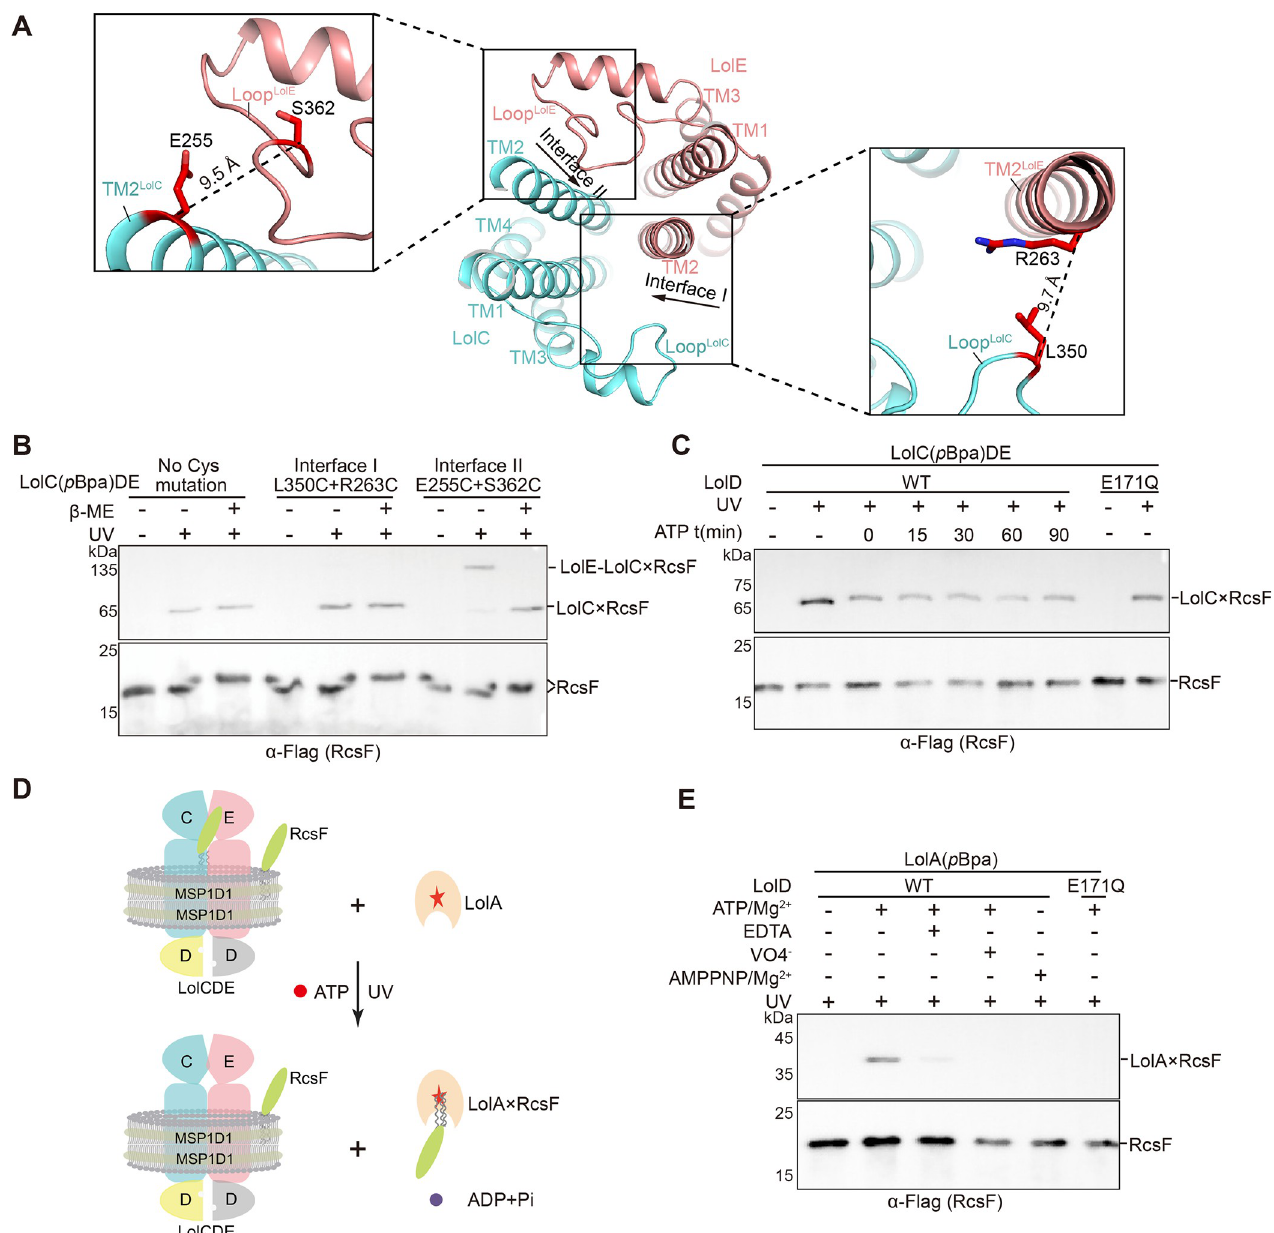
Fig 6. A single path for lipoprotein entry into the V-shaped cavity and energy requirement for lipoprotein transfer to LolA. ( A ) Top view of 2 potential gates (Interface I and Interface II) for lipoprotein entry (middle). Zoom-in view of 2 pairs of residues replaced with cysteines in (B). ( B ) In vitro photo- crosslinking. LolC L256 p BPA DE that contain 2 cysteine mutations or not were reconstituted with RcsF in nanodisc. The LolE-LolC × RcsF adducts were detected by immunoblotting. ( C ) LolC L256 p BPA DE that contain either wild-type LolD or LolD (E171Q) were reconstituted with RcsF in nanodisc. The adducts were evaluated by exposing to UV radiation with or without addition of ATP and Mg 2+ . ( D ) Scheme of an in vitro one-cycle lipoprotein transfer to LolA. Addition of LolA (W70 p BPA), along with ATP and Mg 2+ , leads to transfer of RcsF from LolCDE to LolA. ( E ) Nanodisc-embedded RcsF-LolCDE proteins that contain either wild-type LolD or LolD (E171Q) were incubated with LolA (W70 p BPA) and nucleotides. The ability to transfer RcsF to LolA (W70 p BPA) from LolCDE was probed. Data shown in (B, C and E) are representatives of 3